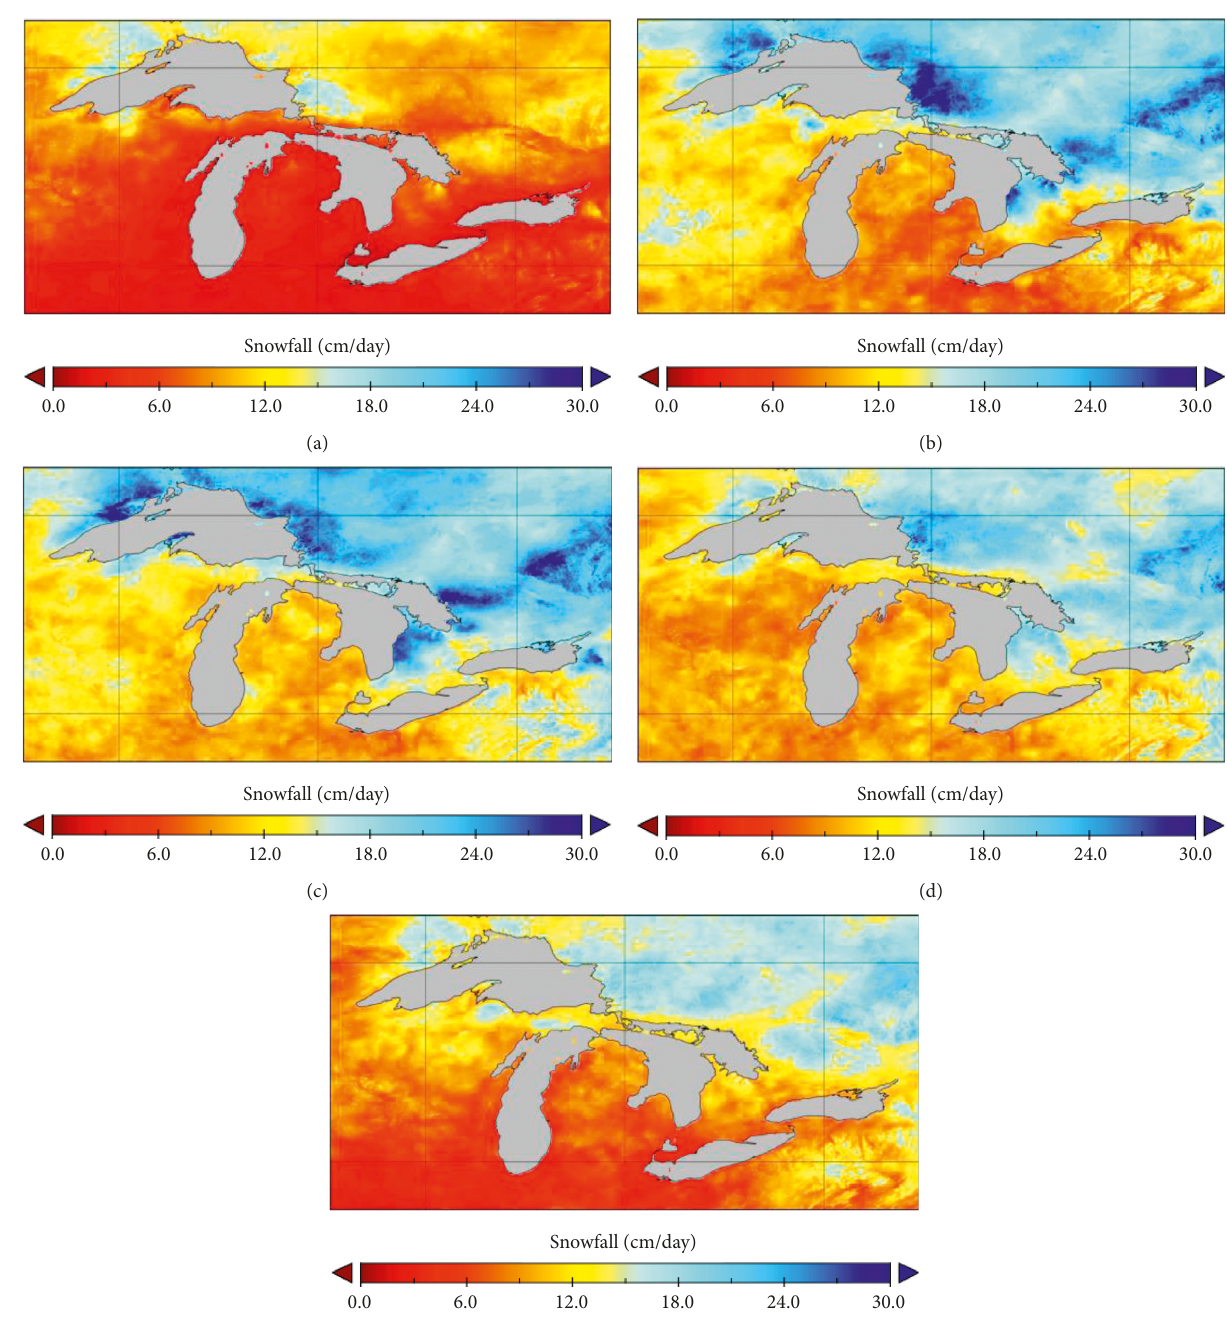
Figure 2: Extreme snowfall intensity for each month of the cold season: (a) November, (b) December, (c) January, (d) February, and (e) March, defined as the 99th percentile of daily snowfall between 1980 and